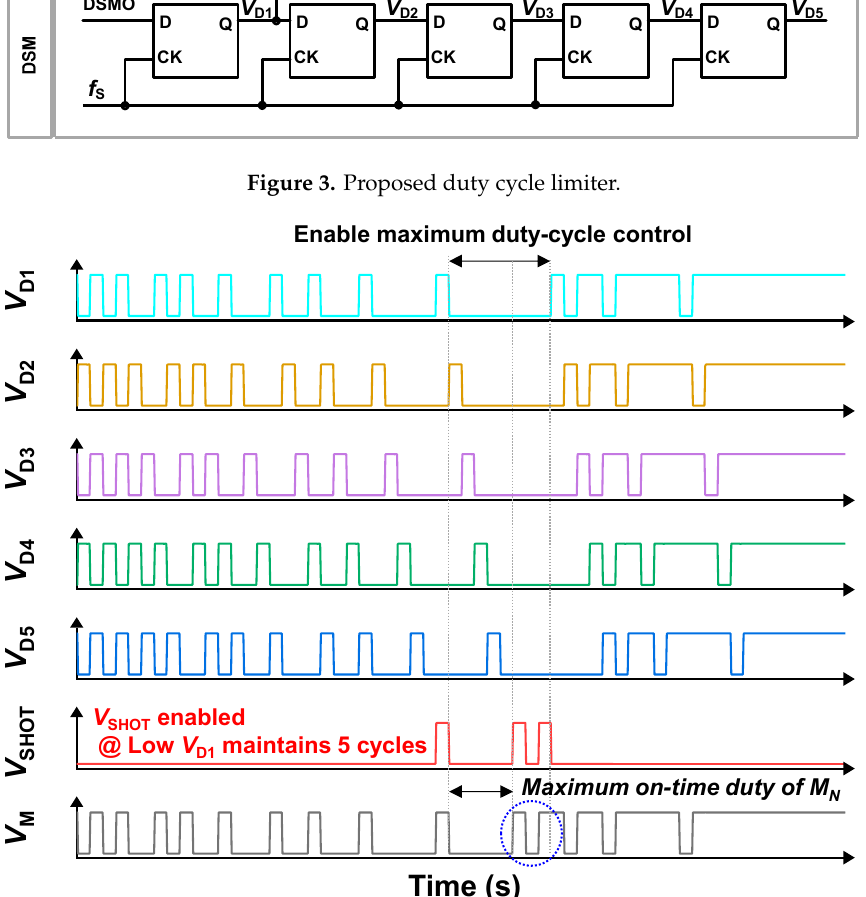
Figure 4. Simulation results of the proposed duty cycle control.